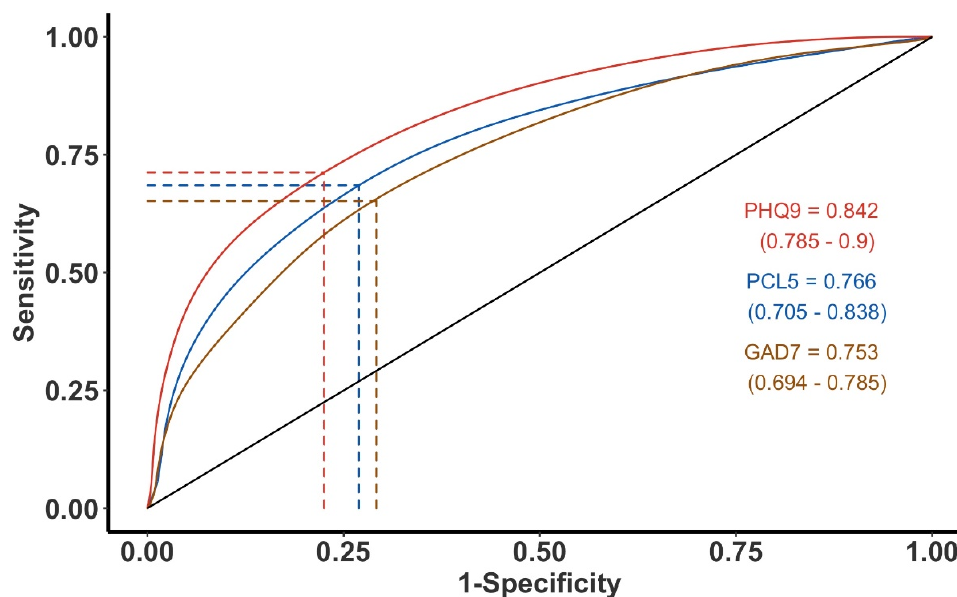
Figure 1. The receiver operating characteristic curve (ROC) for Patient Health Questionnaire 9 (PHQ-9), Post-Traumatic Stress Disorder (PCL-5), and Generalized Anxiety Disorder (GAD-7) and their correlations with Post-Hurricane Distress Scale (PHDS). The K6 ROC plot was homologous to the others and was excluded for legibility. The vertical and horizontal lines are the maximum for the 1-specifity and sensitivity intercepts; the optimal compromise between the specificity and sensitivity defined by Youden’s J index. The values in parenthesis are the 95% confidence intervals of each the Youden’s indices. Table 3. PHDS High Risk cut-off selection based on PCL-5, GAD-7, PHQ-9 and Multi-Index Hy- brid Receiver Operator Characteristic (ROC) Curve Analyses. Sens, spec = sensitivity, specificity, LR+ = Positive Likelihood Ratio, FP =False Positives, TN = True Negatives, FN = False Negatives, TP = True Positives, FPR = False Positive Rate, FNR = False Negative Rate.